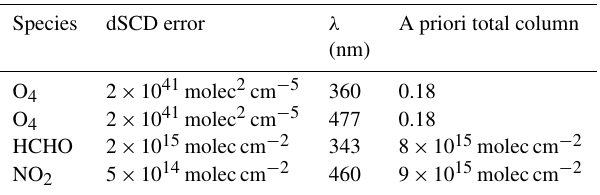
Table 6. Assumed measurement errors of the O 4 , HCHO, and NO 2 dSCDs, as well as total columns of the respective a priori profiles. Units for the errors are molec 2 cm − 5 for O 4 and moleccm − 2 for HCHO and NO 2